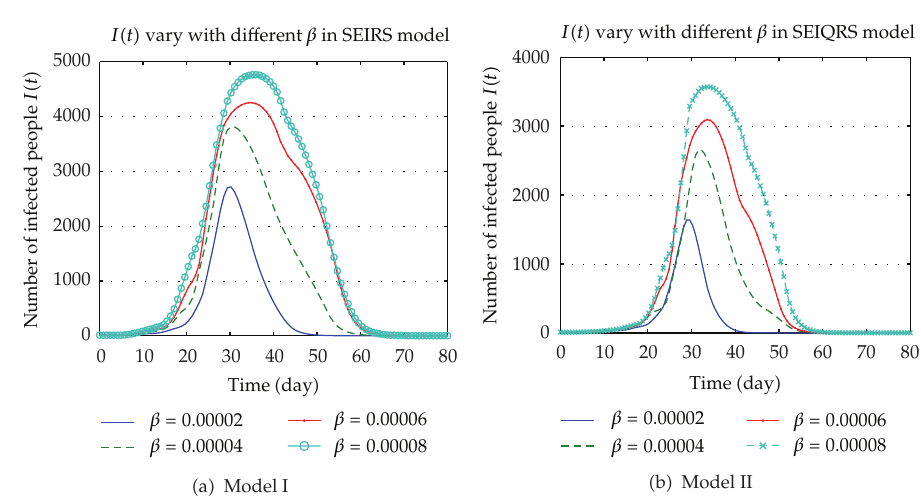
Figure 4: Number of infected people with di ff erent β